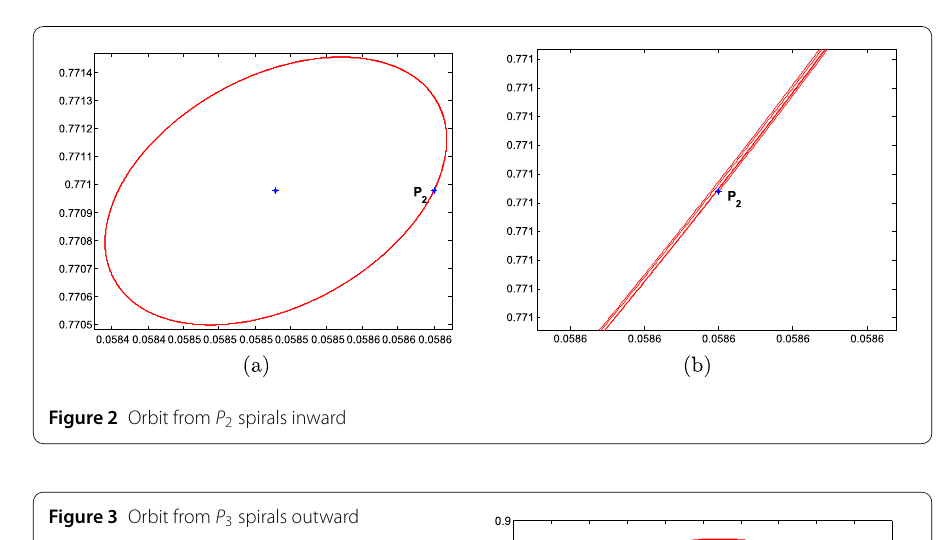
Figure 3 Orbit from P 3 spirals